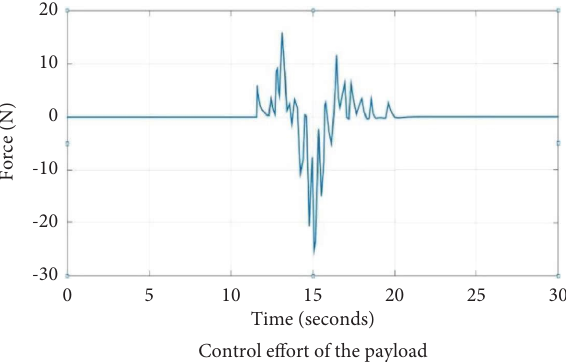
Figure 9: :System exerted efort with the second input signal using hybrid controllers.